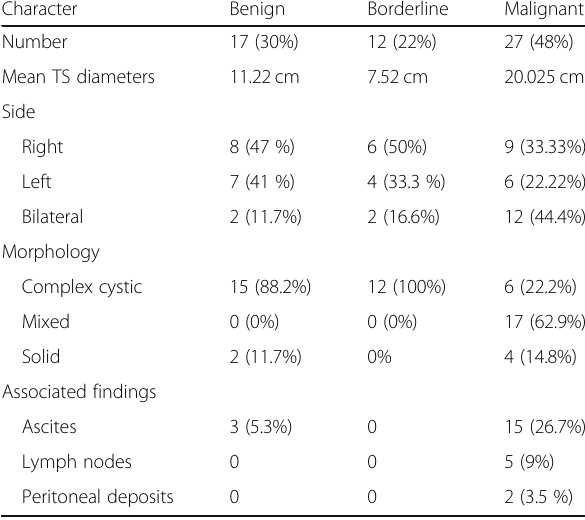
Table 4 Summary of conventional MRI